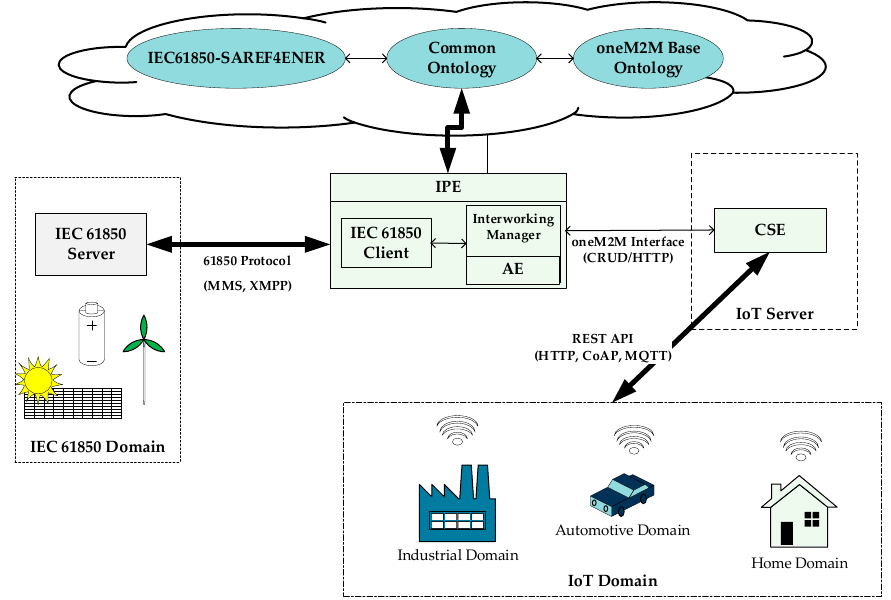
Figure 13. Interworking Architecture based on IPE and Common Ontology.